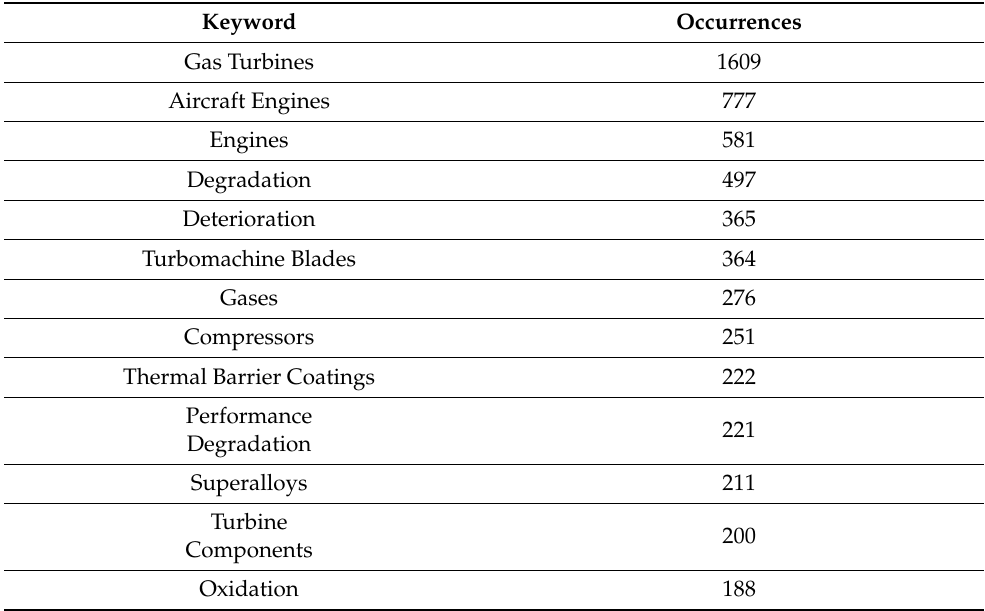
Table 1. Active keywords in the field of gas turbine degradation.